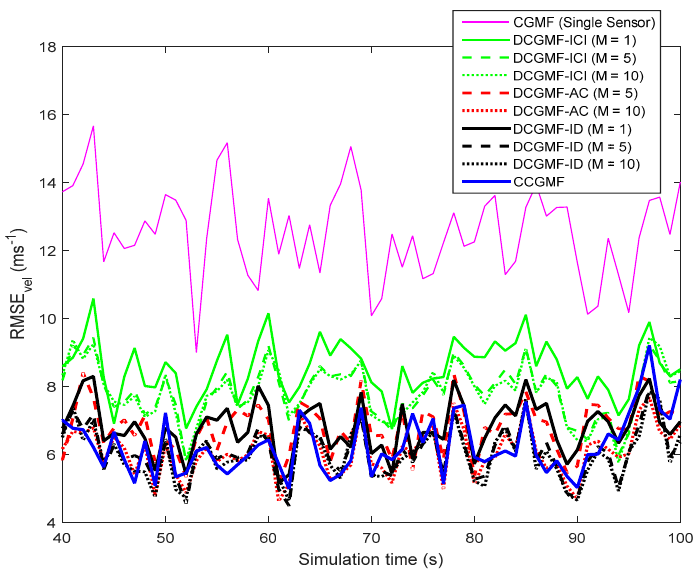
Figure 4. RMSEs of the velocity estimation.